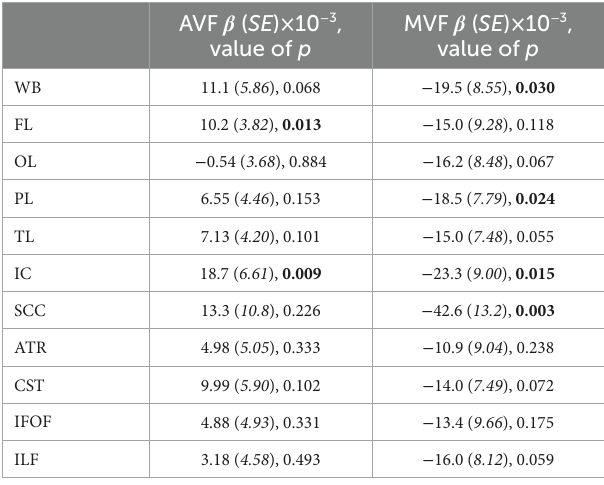
TABLE 2 Regression coefficient ( β ) (standard error ( SE ) in italics), and significance (value of p ) of g -ratio vs. PWV or age across 11 WM ROIs.